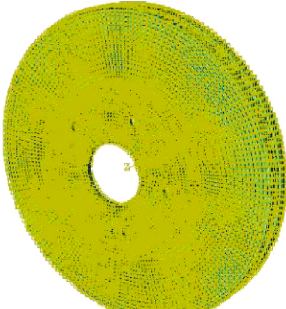
Figure 8: Surface heat dissipation